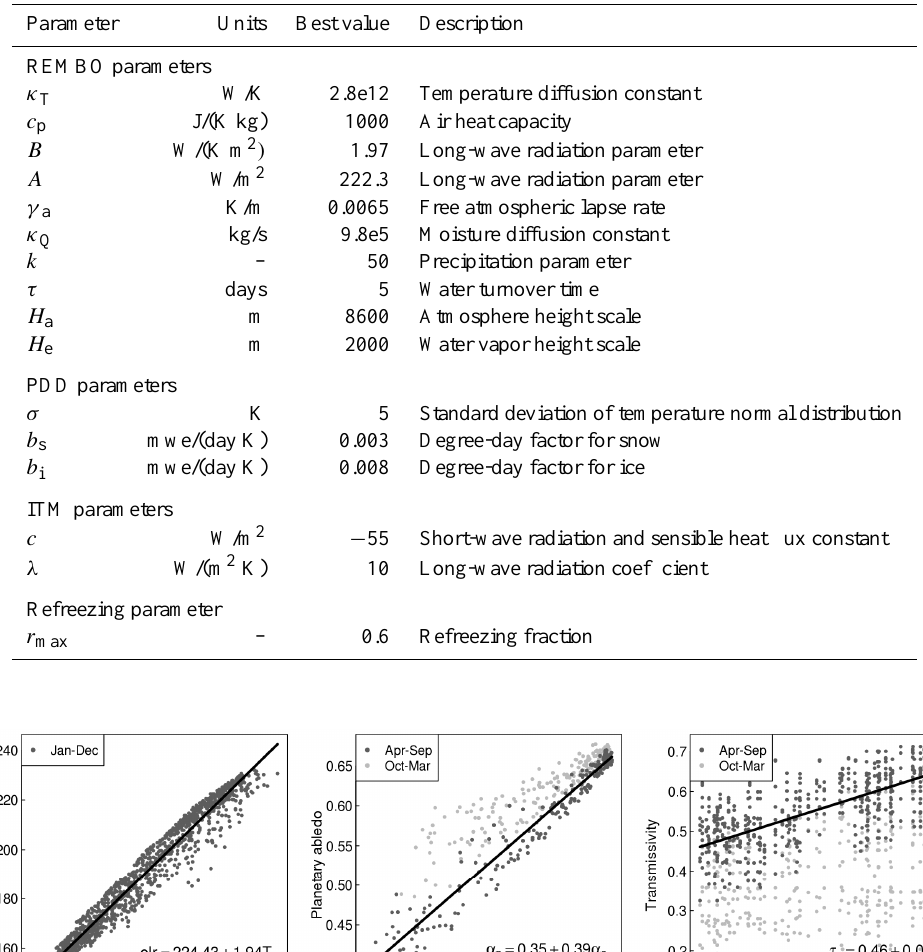
Table 1. Selected parameters used in REMBO and the two melt models, PDD and ITM.